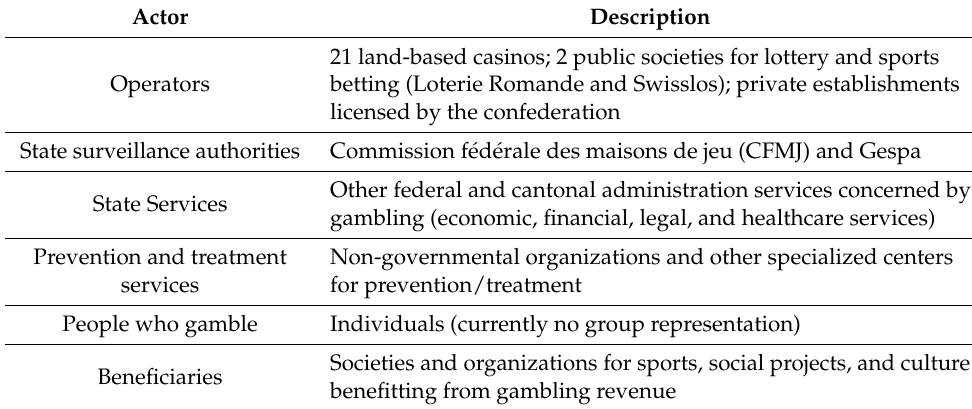
Table 1. Types of